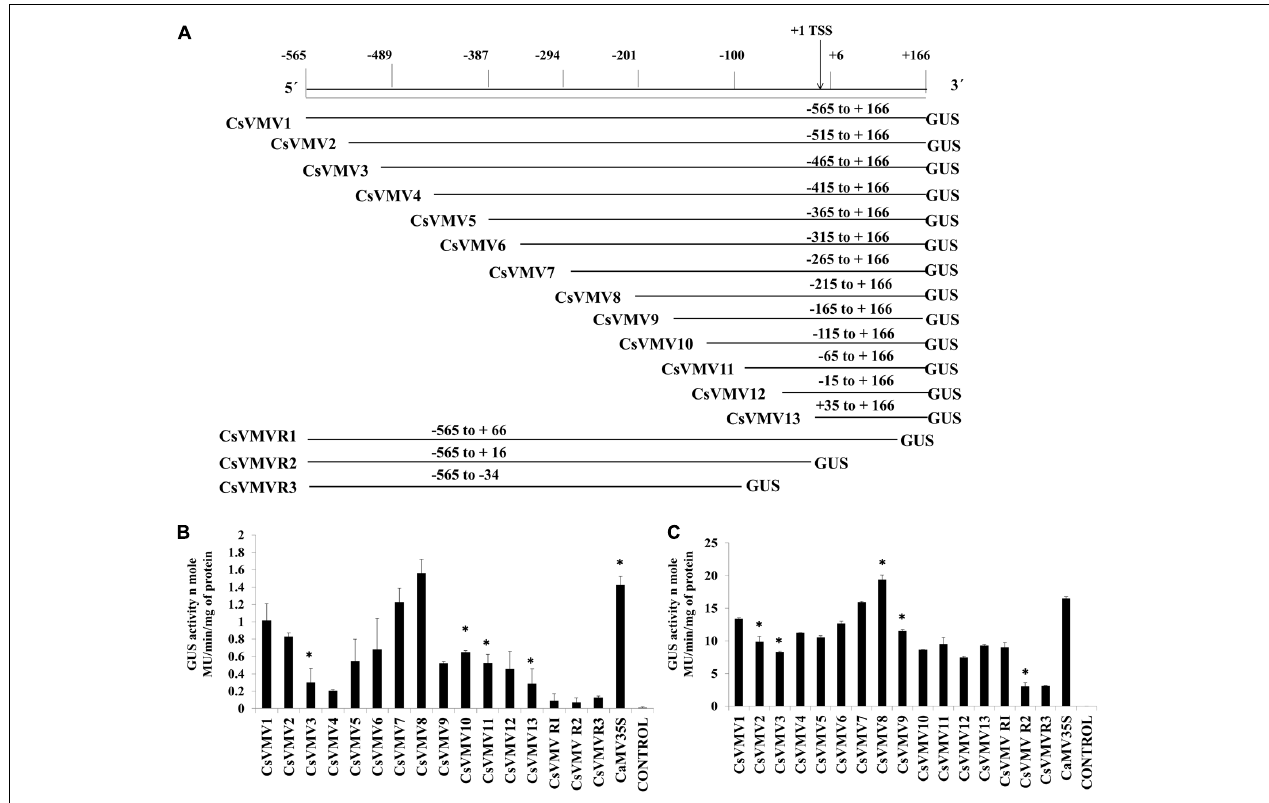
FIGURE 1 | 5 (cid:48) –3 (cid:48) and 3 (cid:48) –5 (cid:48) end deletion analysis of CsVMV promoter fragment. (A) Schematic representation of deletion constructs (16 numbers) coupled to GUS reporter gene and their respective co-ordinates. The relative positions of TATA-box and TSS are shown. (B) Transient protoplast GUS expression analysis of the above mentioned deletion constructs in tobacco protoplasts. (C) Transient GUS activities of the promoter deletion constructs in whole plant of Nicotiana tabacum Samsun NN following Agro-infiltration assays. Average GUS activities (nmole MU/min/mg protein) of three independent experiments obtained from transformed protoplasts and agro-infiltration assays for above deletion constructs were presented with respective SD. Asterisks indicate level of significance where “ ∗∗ ” is more significant than “ ∗